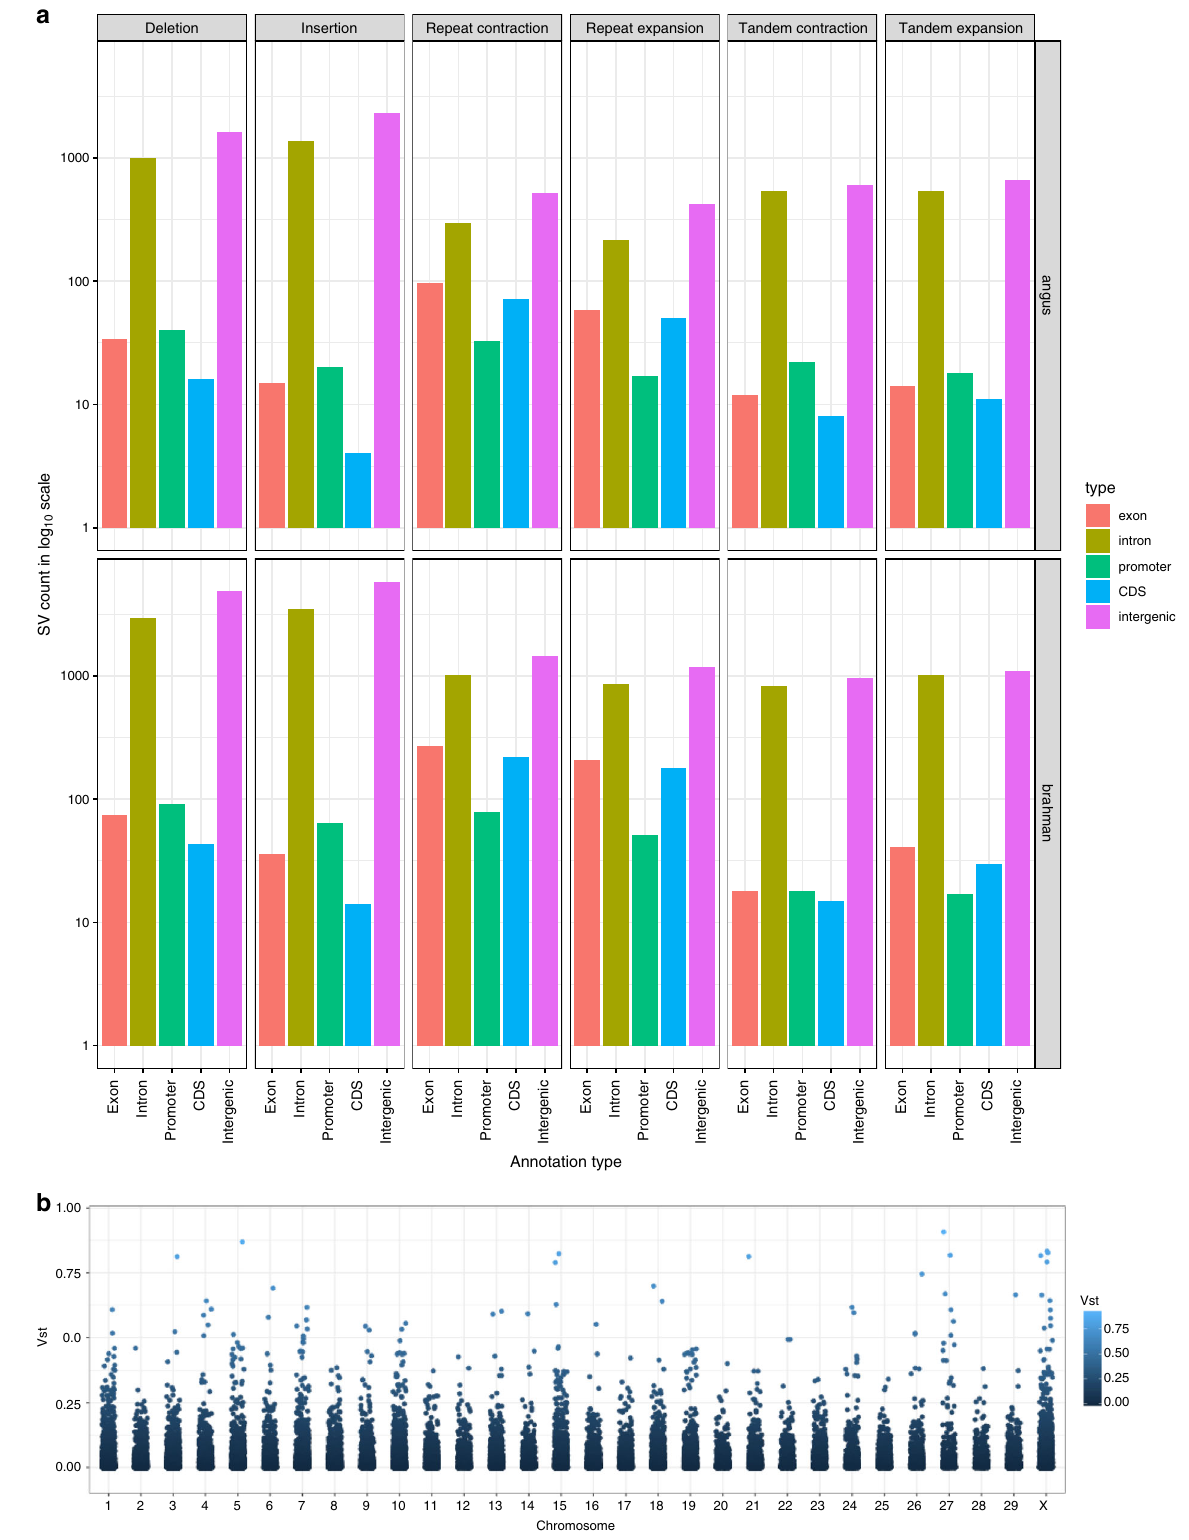
Fig. 4 Comparison of structural variants between Brahman and Angus. a Count in log 10 scale of 6 classes of SVs when overlapped with various annotation types. b Population differentiation for copy number variation as estimated by V st along each chromosome for the taurine and indicine comparison using UOA_Brahman_1 as the